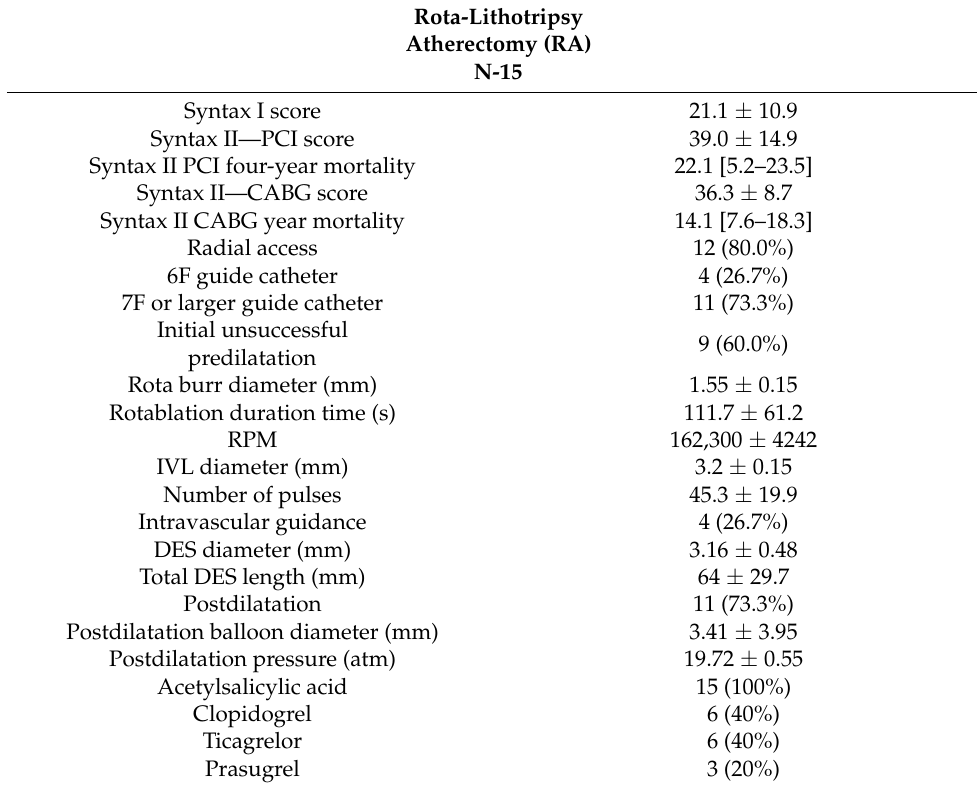
Table 2. The baseline procedural features of both study